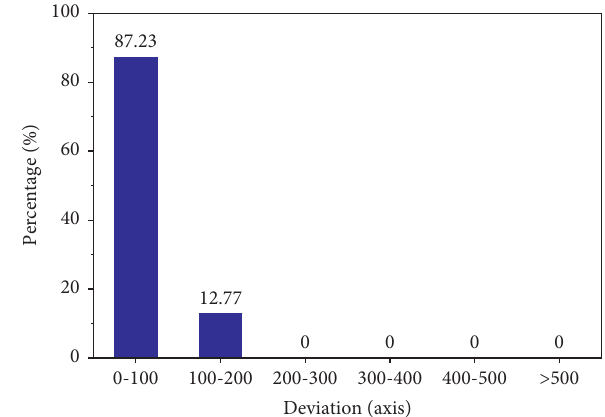
Figure 18: MAE histogram of left-turn trajectory prediction.